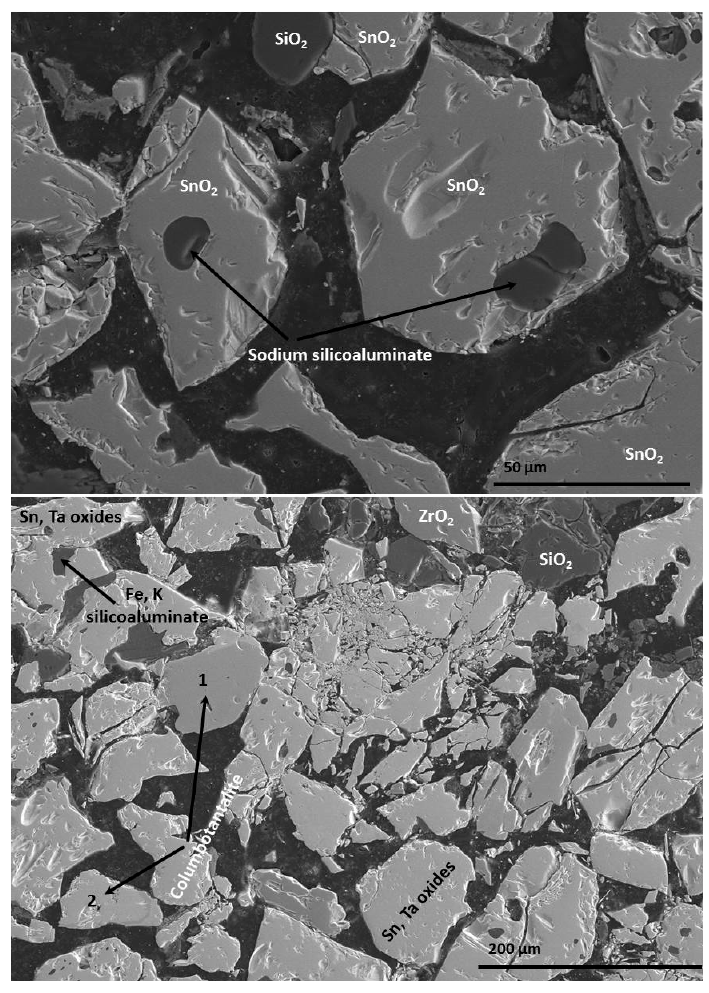
Figure 4. FE-SEM-EDX EDX (Field Emission-Scanning Electron Microscopy-Energy Dispersive X-Ray) images of the mineral concentrate.